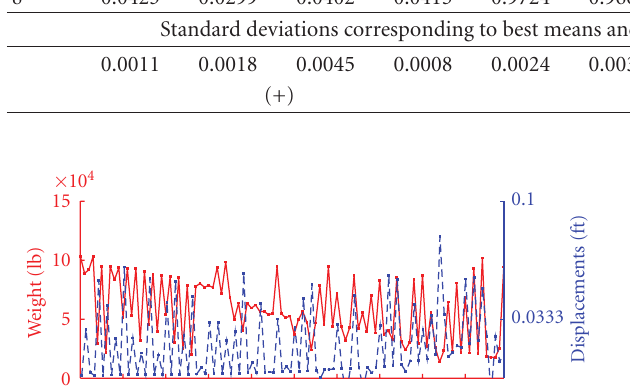
Standard deviations corresponding to best means and assessment of significance levels according to statistical tests